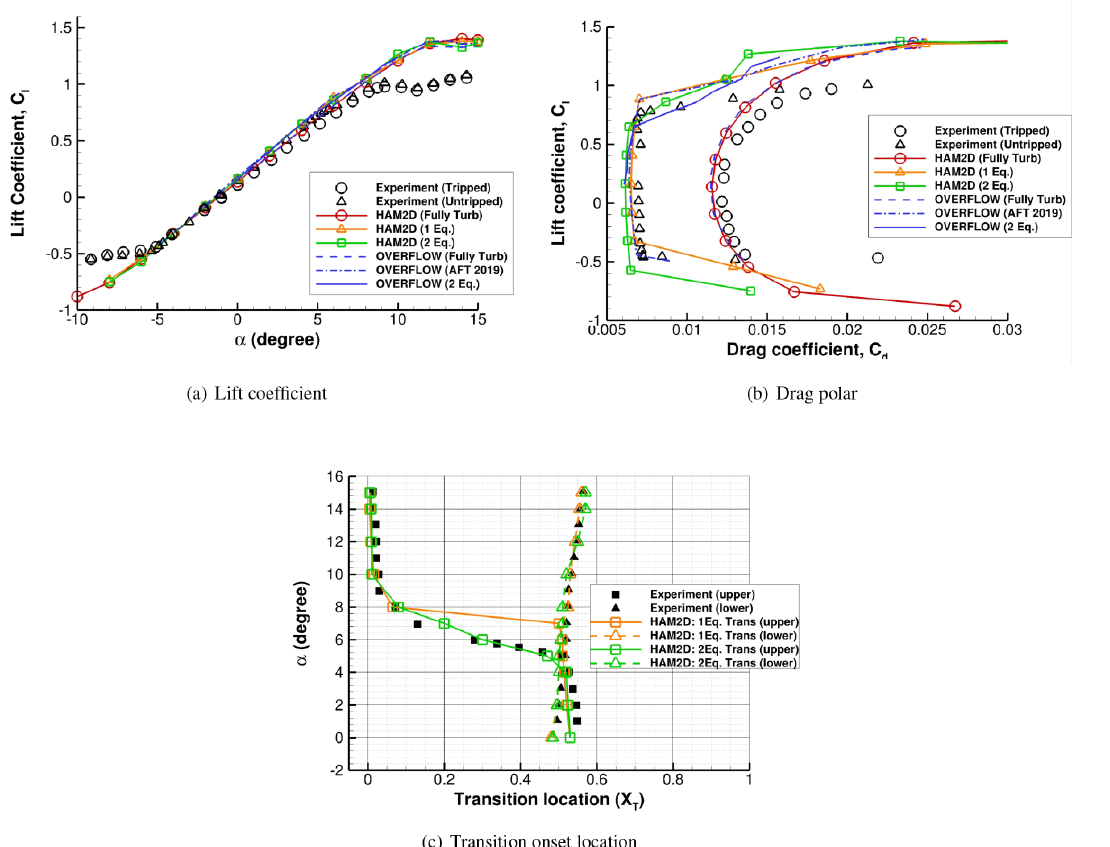
Figure 4. Comparison of (a) lift polar, (b) drag polar, and (c) transition onset location for the S809 airfoil at Re = 2 × 10 6 predicted by HAM2D using a fully turbulent flow approximation and one-equation and two-equation transition models with experimental data (Somers, 1997). Also shown are reference predictions using the NASA OVERFLOW solver using fully turbulent flow approximation, the AFT2019 transition model (Coder, 2019), and the two-equation transition model (Hall,